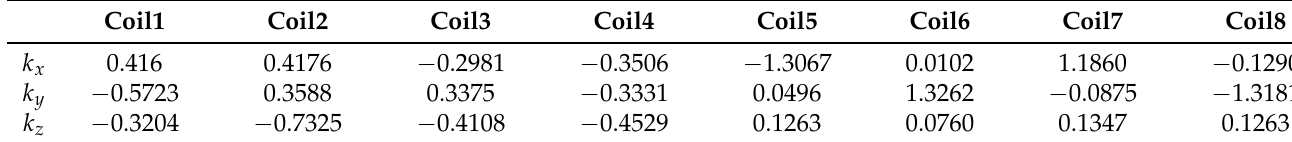
Table 3. Linear coefficient between magnetic field and input current for each coil.